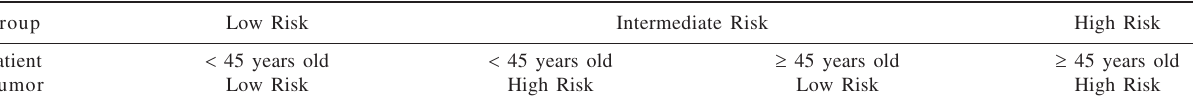
Table 1 – Risk groups according to AMES 4 prognostic index. Group